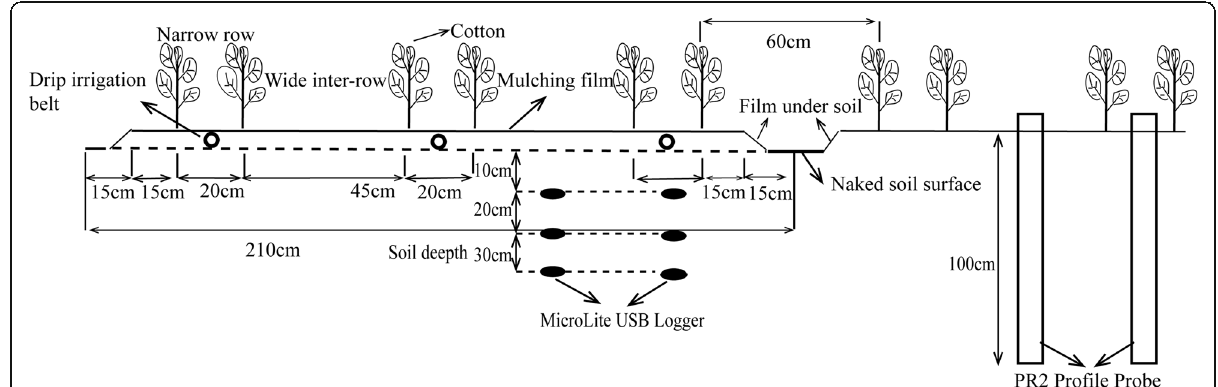
Fig. 1 Cropping pattern and burial depth of MicroLite USB Loggers and PR2 Profile Probe in the mulching film-removal field